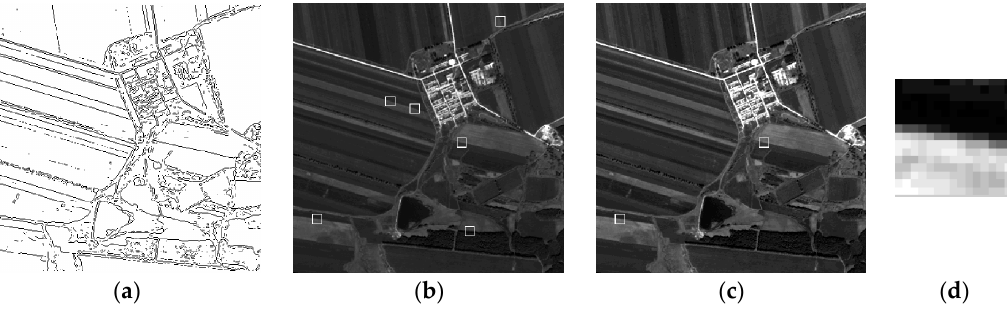
Figure 13. Process of extracting the edge region by using the novel slant knife-edge method. ( a ) Edge detection by canny algorithm; ( b ) all knife-edge areas are described in white boxes; ( c ) preferred knife-edge areas; ( d ) selected knife-edge area. Table 5 . List of the center coordinates of knife-edge areas.